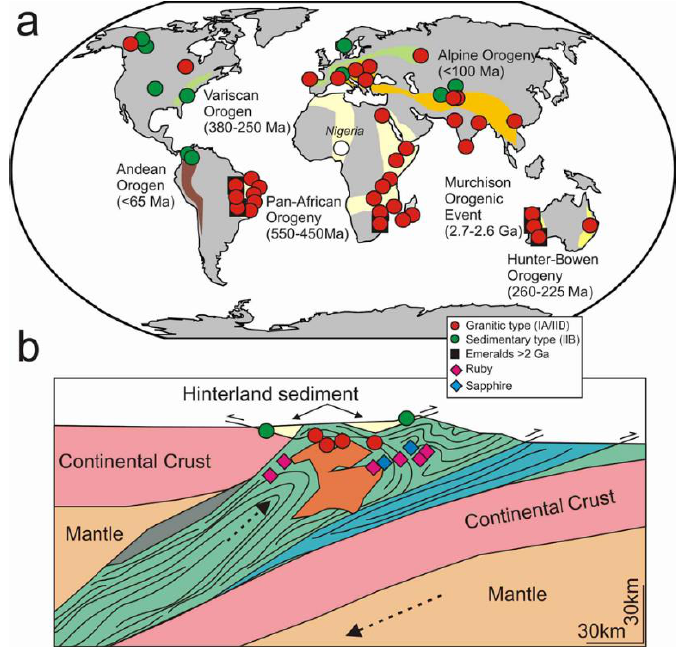
Figure 8. ( a ) Emerald types associated with major orogenic events in Earth history and; ( b ) relative distribution of emeralds, rubies and sapphires in continental collision events (modified after [52]). In ( a ), emerald deposits >2 billion years are shown with a black square outline, including the South African samples analyzed here. Orogenic events and rough geographic distribution are shown with colors. In ( b ), approximate mineralization locations as well as compositions are shown relative to ruby and sapphire formation depths. Rocks in green and blue are metamorphosed sediments and in dark orange are intrusive granitic bodies, with continental crust shown in pink and the mantle in light orange.